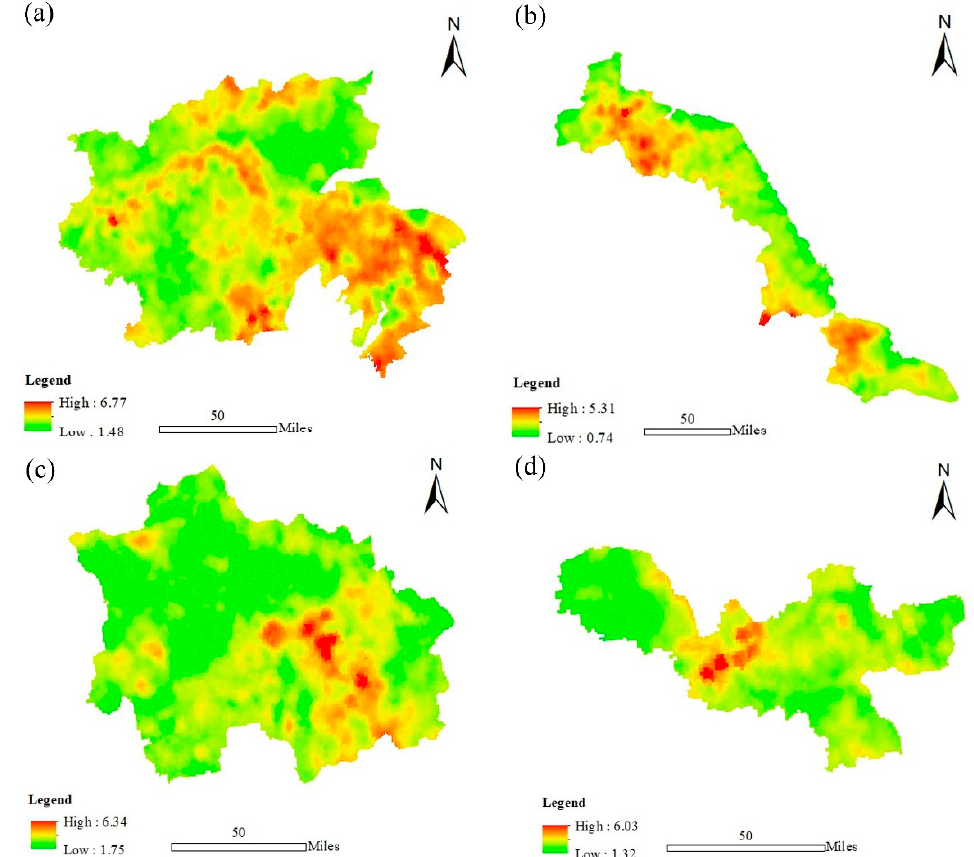
Figure 3. The spatial distributions of soil organic carbon density (SOCD) in four functional regions (kg/m 2 ); ( a ), ( b ), ( c ) and ( d ) represent the Yangtze River City Group, Coastal Economic Belt, Jianghuai Ecological Economic Region and Huaihai Economic Region,